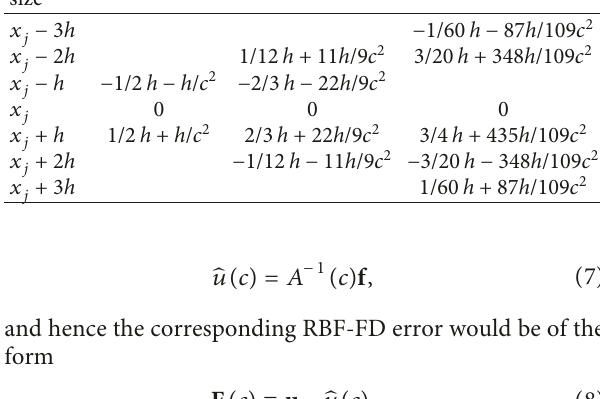
Table 1: Series expansions of IQ-RBF-FD weights for u ′ . Stencil 3 nodes 5 size